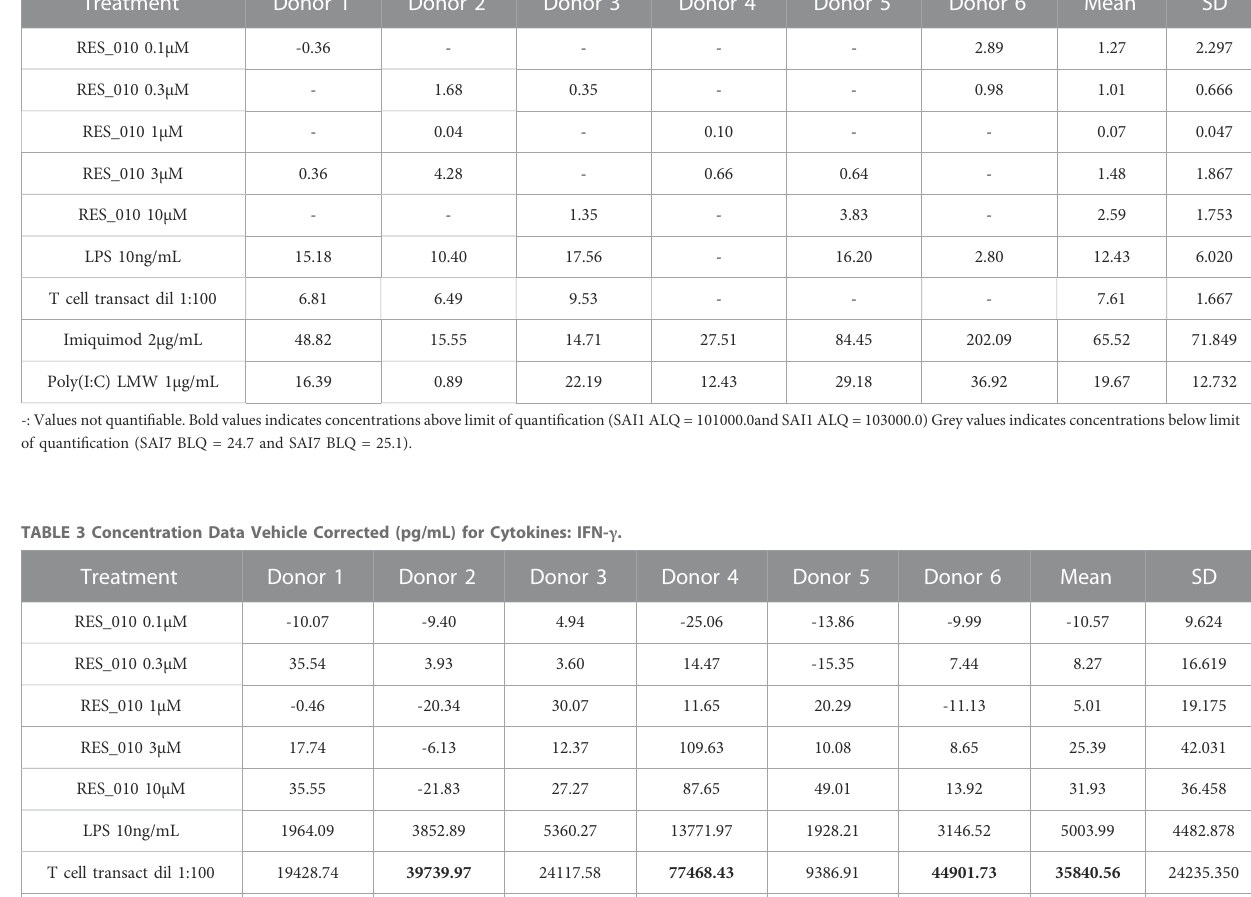
TABLE 2 Concentration Data Vehicle Corrected (pg/mL) for Cytokines: IFN- β . Treatment Donor 1